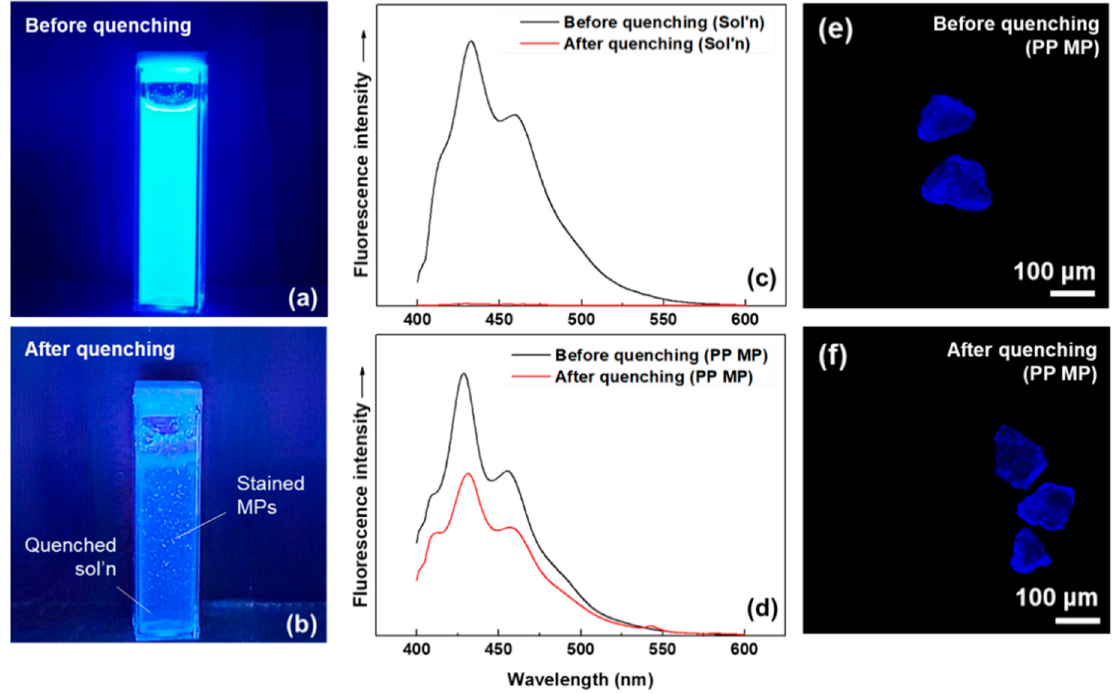
Figure 8. Optical photographs of the aqueous staining solution with PP MPs before ( a ) and after ( b ) quenching with aniline illuminated by UV Hand Lamp at 365 nm. Fluorescence spectra of the aqueous staining solution (without MPs, ( c )) and stained PP MPs ( d ) before and after quenching with aniline. Fluorescence photographs of stained PP MPs before ( e ) and after ( f ) quenching with aniline. Staining conditions: dye = S-FN; surfactant = Tween 20; dye/surfactant = 1 g/L; dye/MP = 2.5 wt%; MP/aqueous solution = 1 g/L; staining time = 60 min; staining temperature = 80 °C. Fluorescence quenching condition: 0.25 M aniline, room temperature.